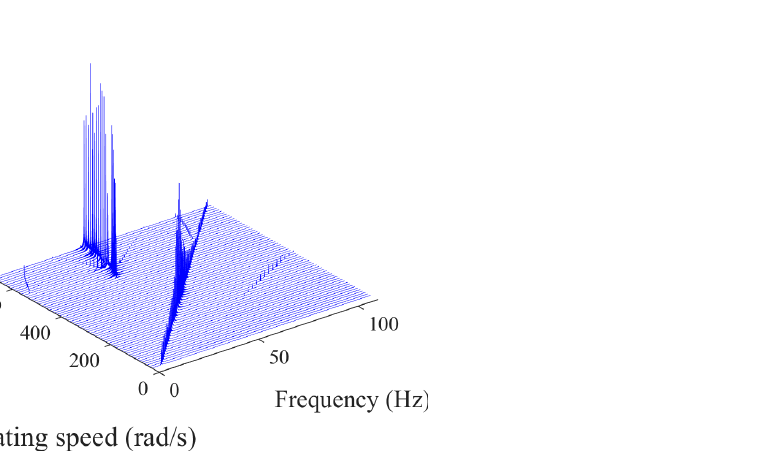
Figure 10. Frequency waterfall chart of the rotating disk along a vertical direction at oil pressure of 0.2 MPa.